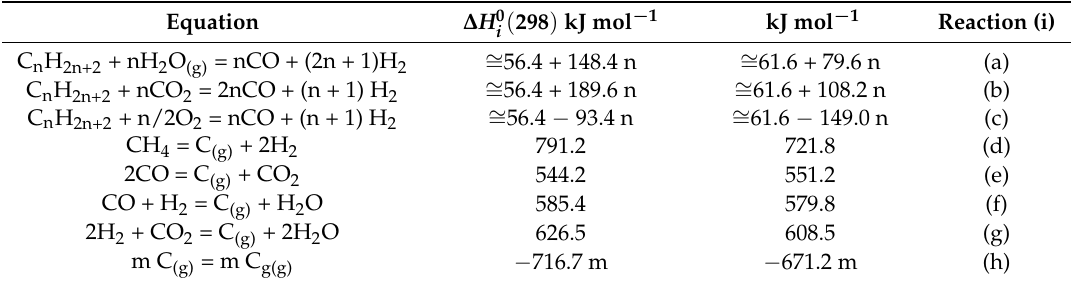
Table 1. Basic reactions and their standard thermodynamic data.